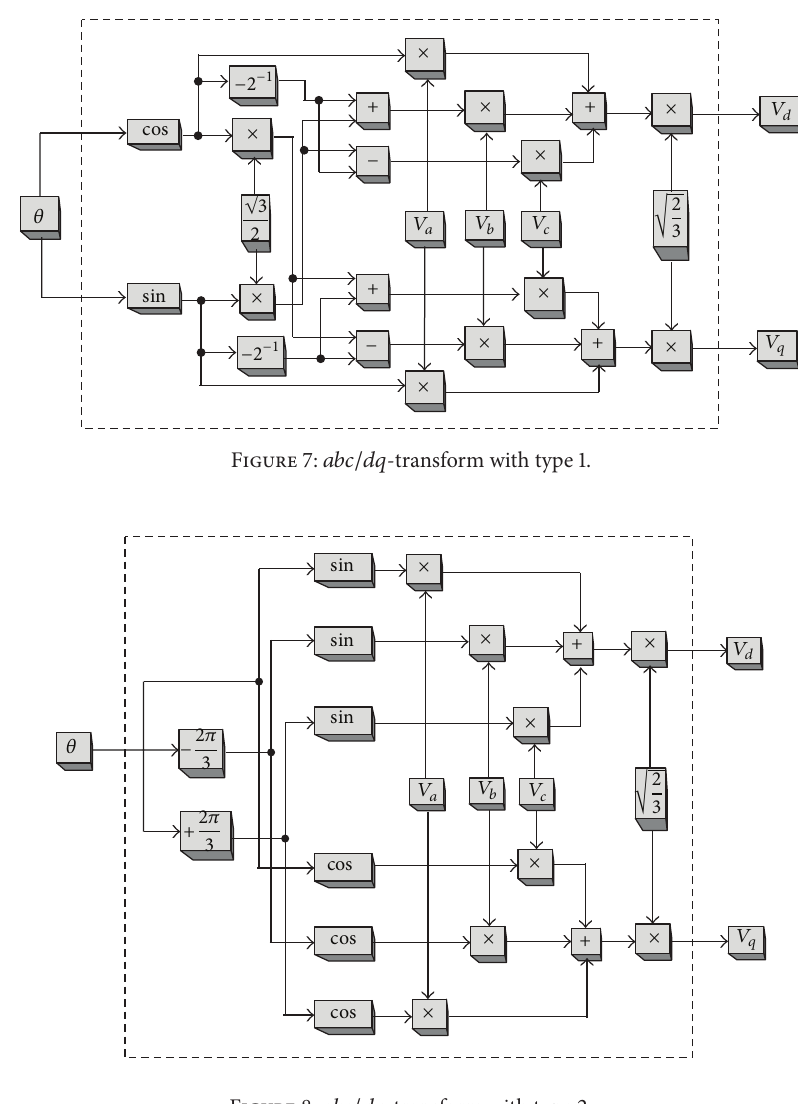
Figure 8: 𝑎𝑏𝑐/𝑑𝑞 -transform with type